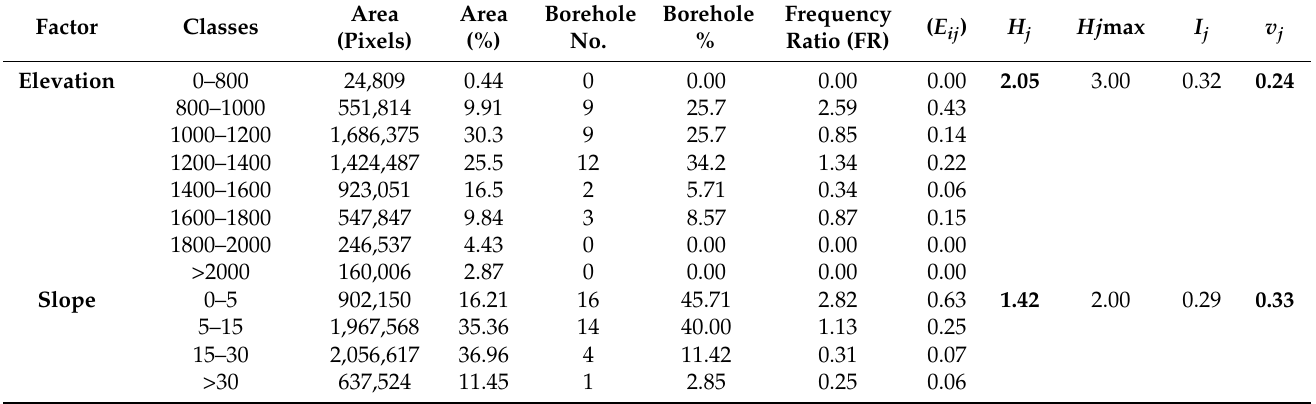
Table 1. Spatial relationship between each conditioning factor and water boreholes using the FR and SE